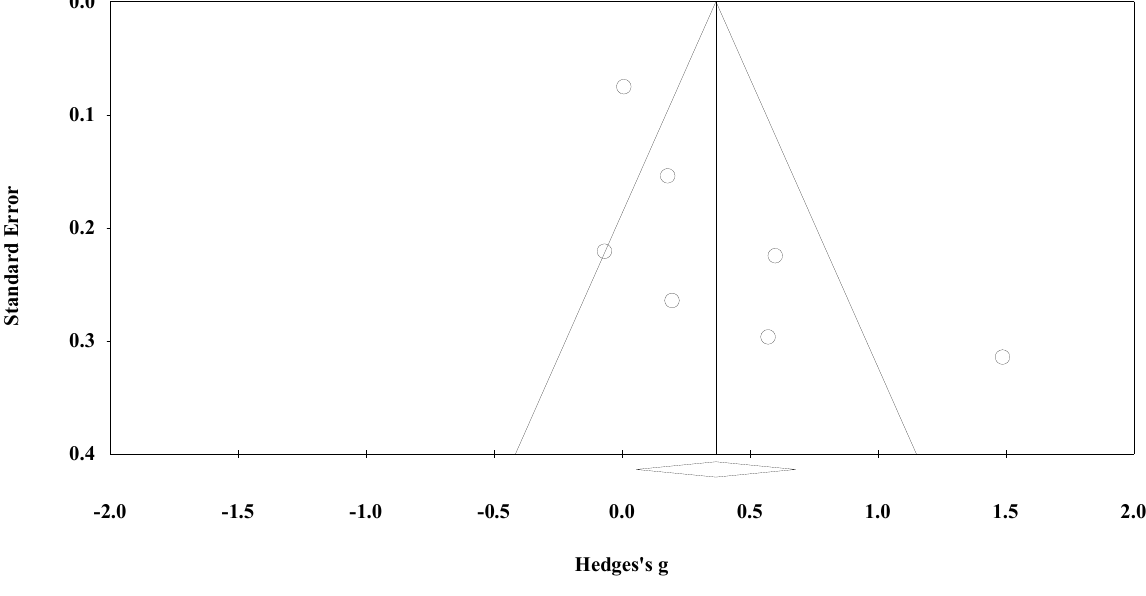
Funnel Plot for the Random Effect Model (Asynchronous vs. Synchronous) for the Cognitive Domain Funnel Plot of Standard Error by Hedges's